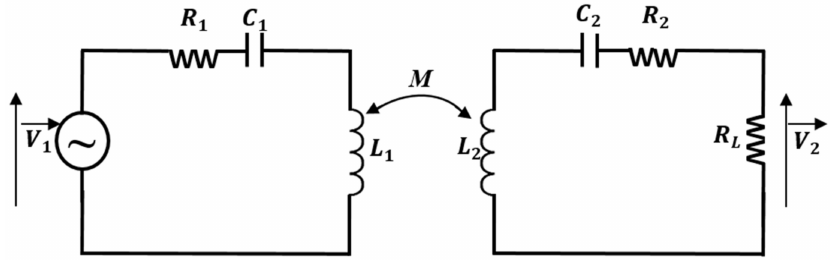
Figure 3. Equivalent circuit of magnetic resonant WPT system.